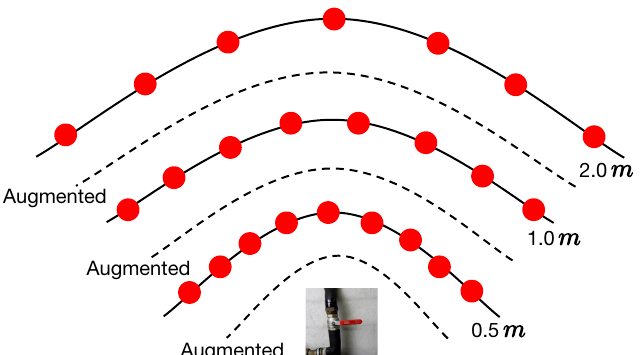
Figure 8. Camera pose augmentation.